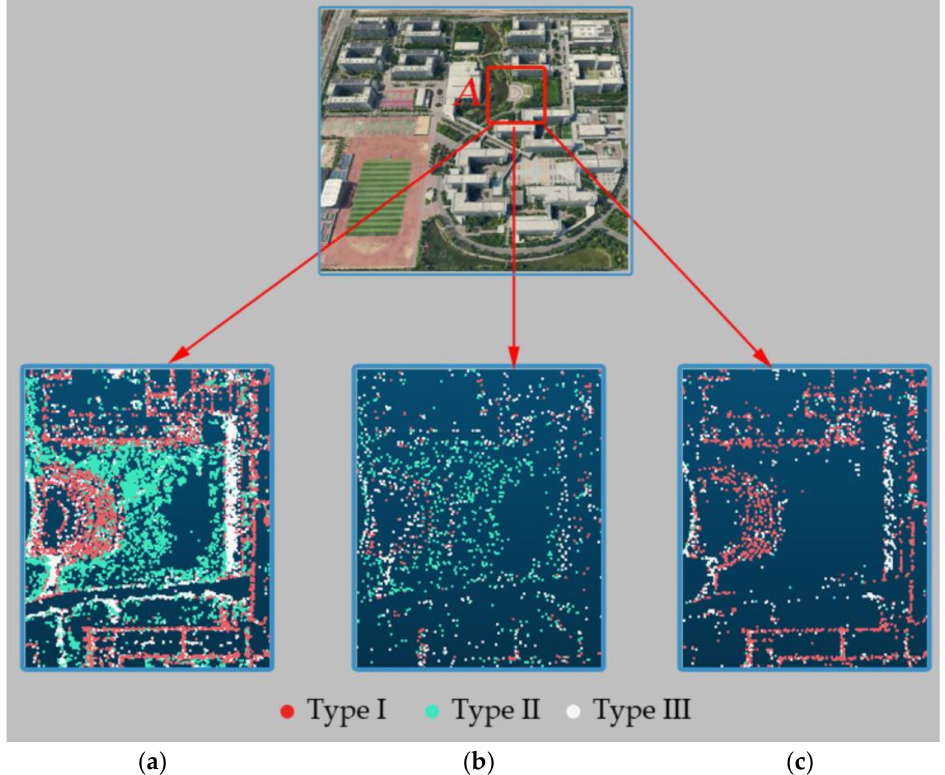
Figure 8. Sparse point cloud of a vegetation area (rectangle A) in an oblique image. ( a ) The result of the original SIFT algorithm, ( b ) the result of Wu method and ( c ) the result of the proposed